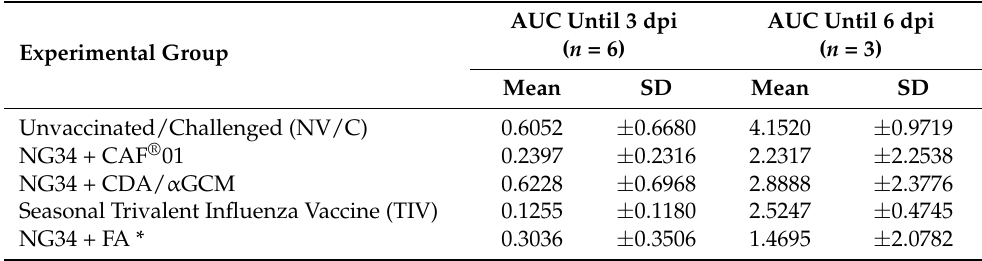
Table 2. Area under the curve calculation of the nasal shedding performed until 3 dpi and 6 dpi.